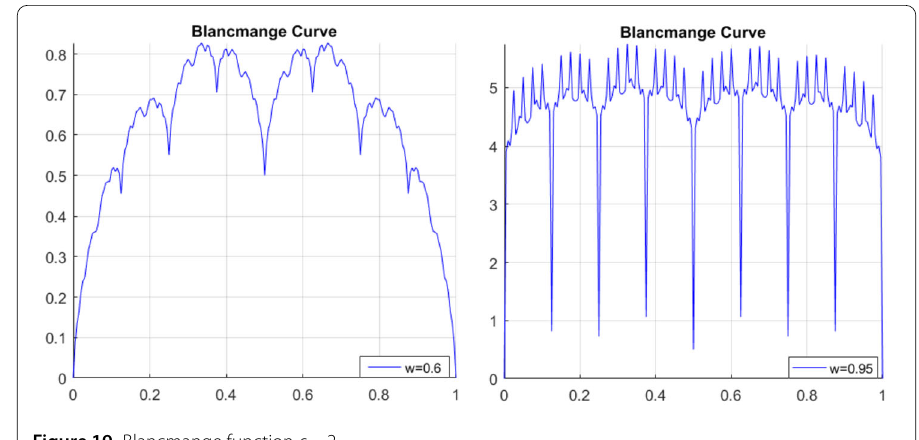
Figure 19 Blancmange function c = 2